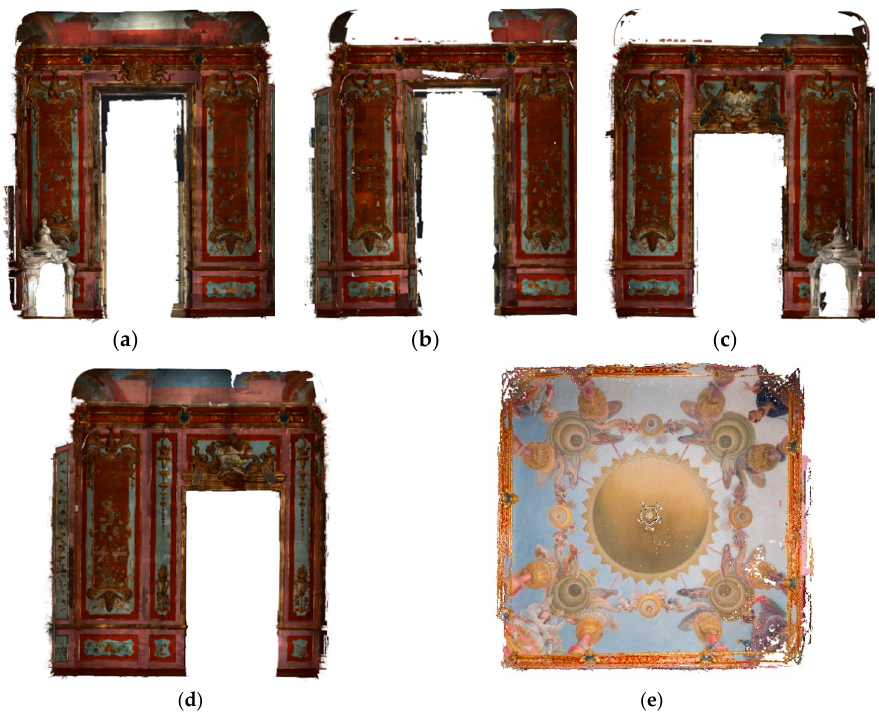
Figure 4. Generated orthographic renders. ( a – d ) Four walls of the Cabinet. ( e ) The ceiling.